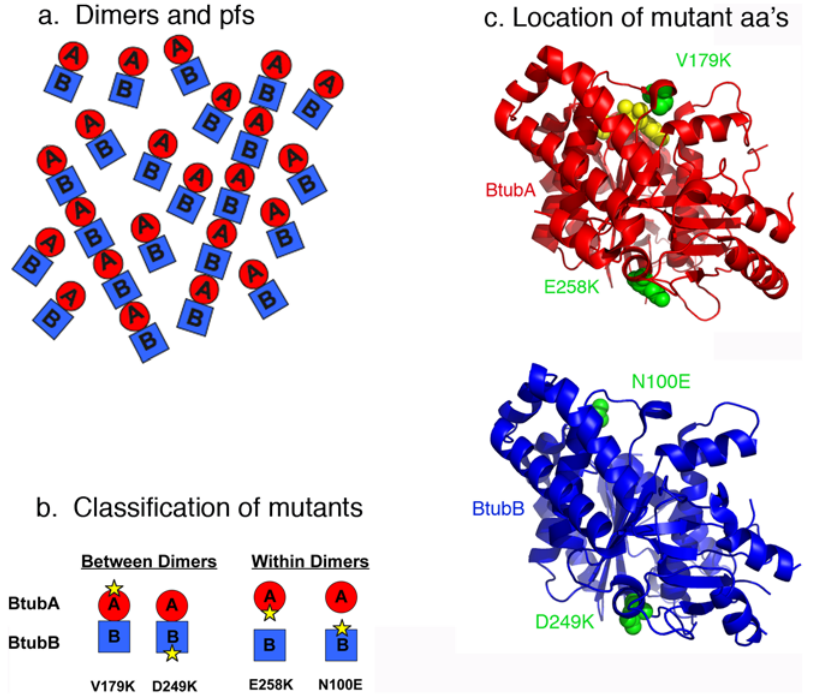
Figure 1. Assembly pathway and location of point mutations in BtubA/B. (a) The proposed assembly pathway in which BtubA and B first assemble into heterodimers, and the heterodimers then further assemble into protofilaments. (b) Two classes of protofilament interface mutants are indicated. One disrupts the interface between dimers, and the other within dimers. The four mutants tested experimentally are indicated. (c) BtubA and BtubB are shown separately in ribbon diagram, and the mutated amino acids are shown in green spacefill. GDP in BtubA is in yellow spacefill. The figures were created in PyMol (DeLano Scientific) from the PDB file 2BTQ [4].